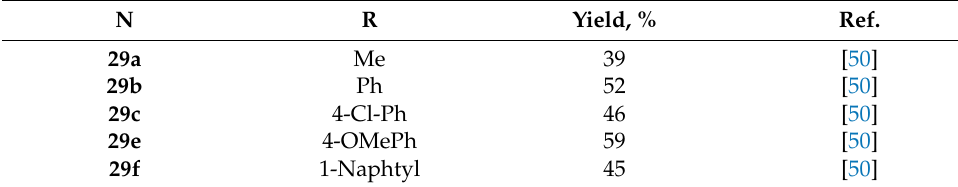
Table 6. Yields of catalytic cycloaddition of acrylates (Scheme 13) to 1-cyanoindolizine. N R Yield, % Ref.